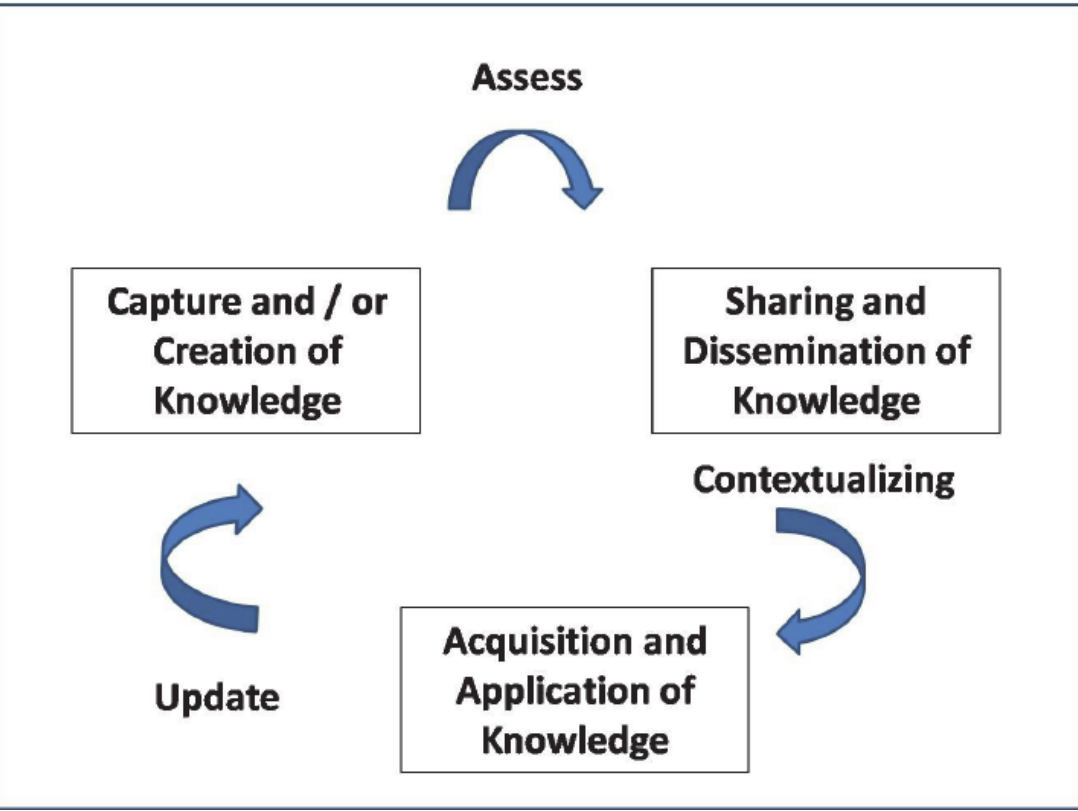
Fig. 1. Knowledge management cycle (Dalkir,